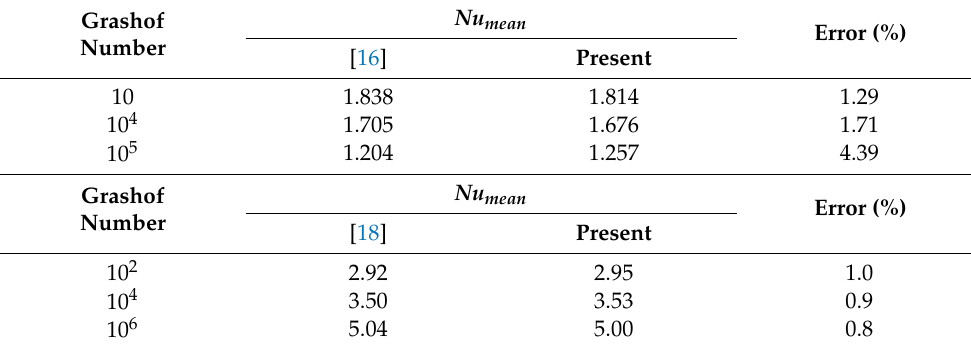
Table 1. Comparison of present surface-averaged Nusselt numbers on the top wall of the cavity at Re = 100 with those reported by Khanafer and Aithal [16] and Ouertatani et al. [18].